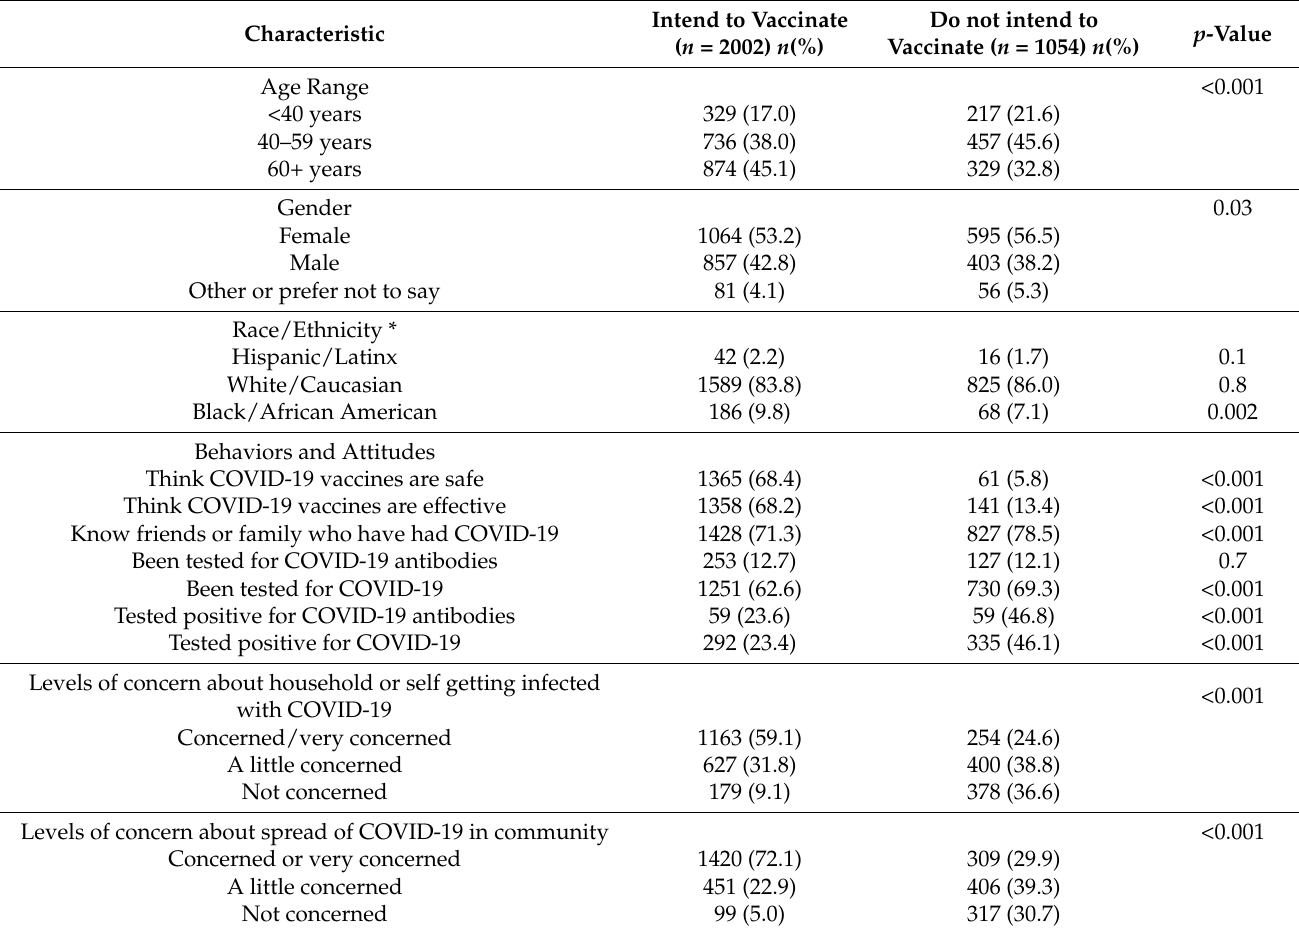
Table 2. Characteristics of unvaccinated participants, categorized by intent to vaccinate. ( n = 3056) †